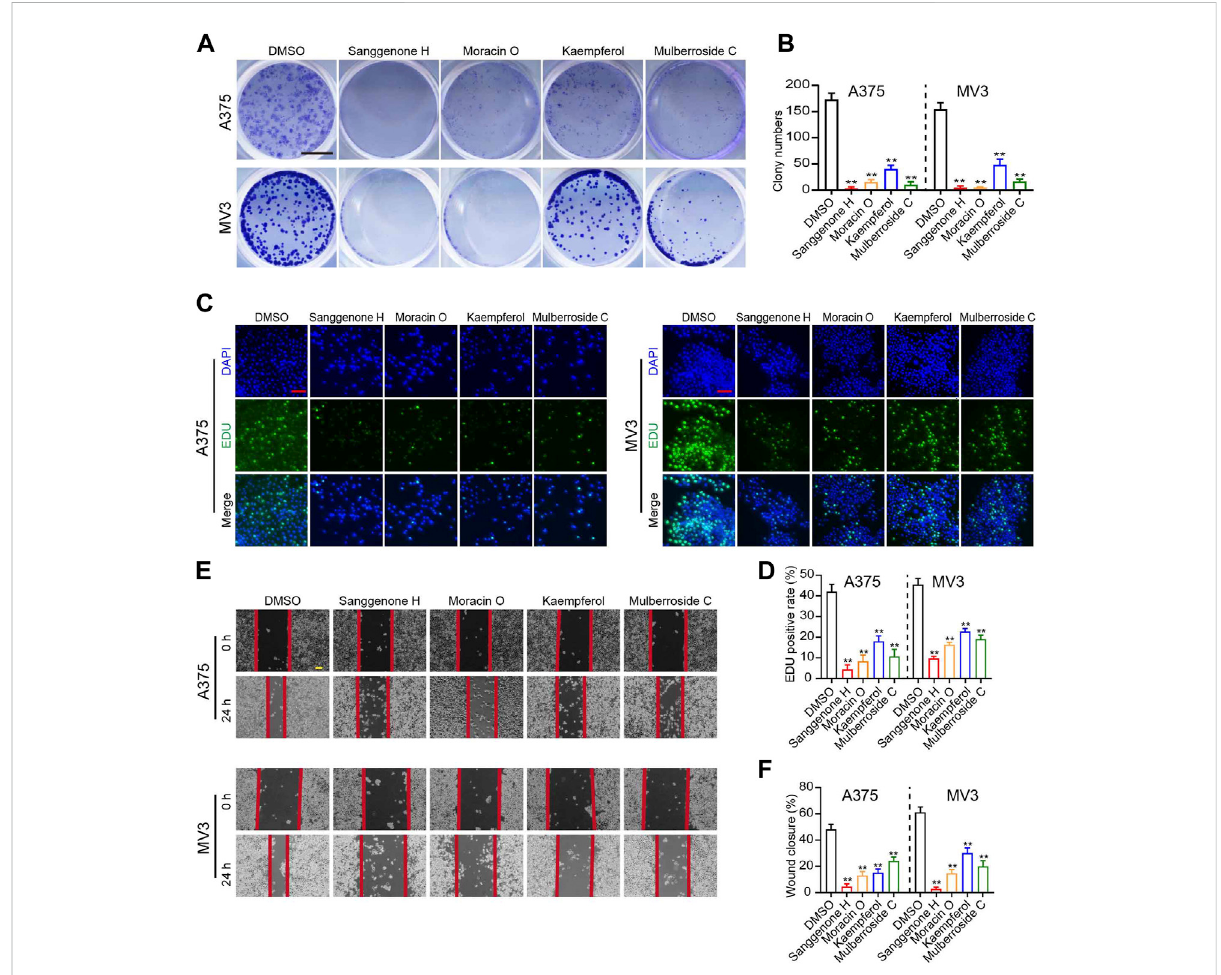
FIGURE 6 Anti-tumoreffectsofpartialbioactivecompoundsextractedfromCMonmelanomacells. (A) Colonyformationassaysand (B) Quanti fi cationof clones on A375 and MV3 cells treated with various bioactive compounds from CM for 7 days. DMSO was used as a control. The cells were stained with crystal violet staining solution. The scale bar indicates 5 mm. (C) Images and (D) quanti fi cation of EdU-positive A375 and MV3 cells treated with various bioactive compounds for 48 h. DMSO was used as a control. Scale bar = 50 μ m. (E) The wounds on cell layers under the incubation of various bioactive compounds or DMSO were observed at 30 h, and (F) the closure rates were calculated. Scale bar = 100 μ m. The asterisks indicate statistically signi fi cant differences (* p < 0.05 and ** p <